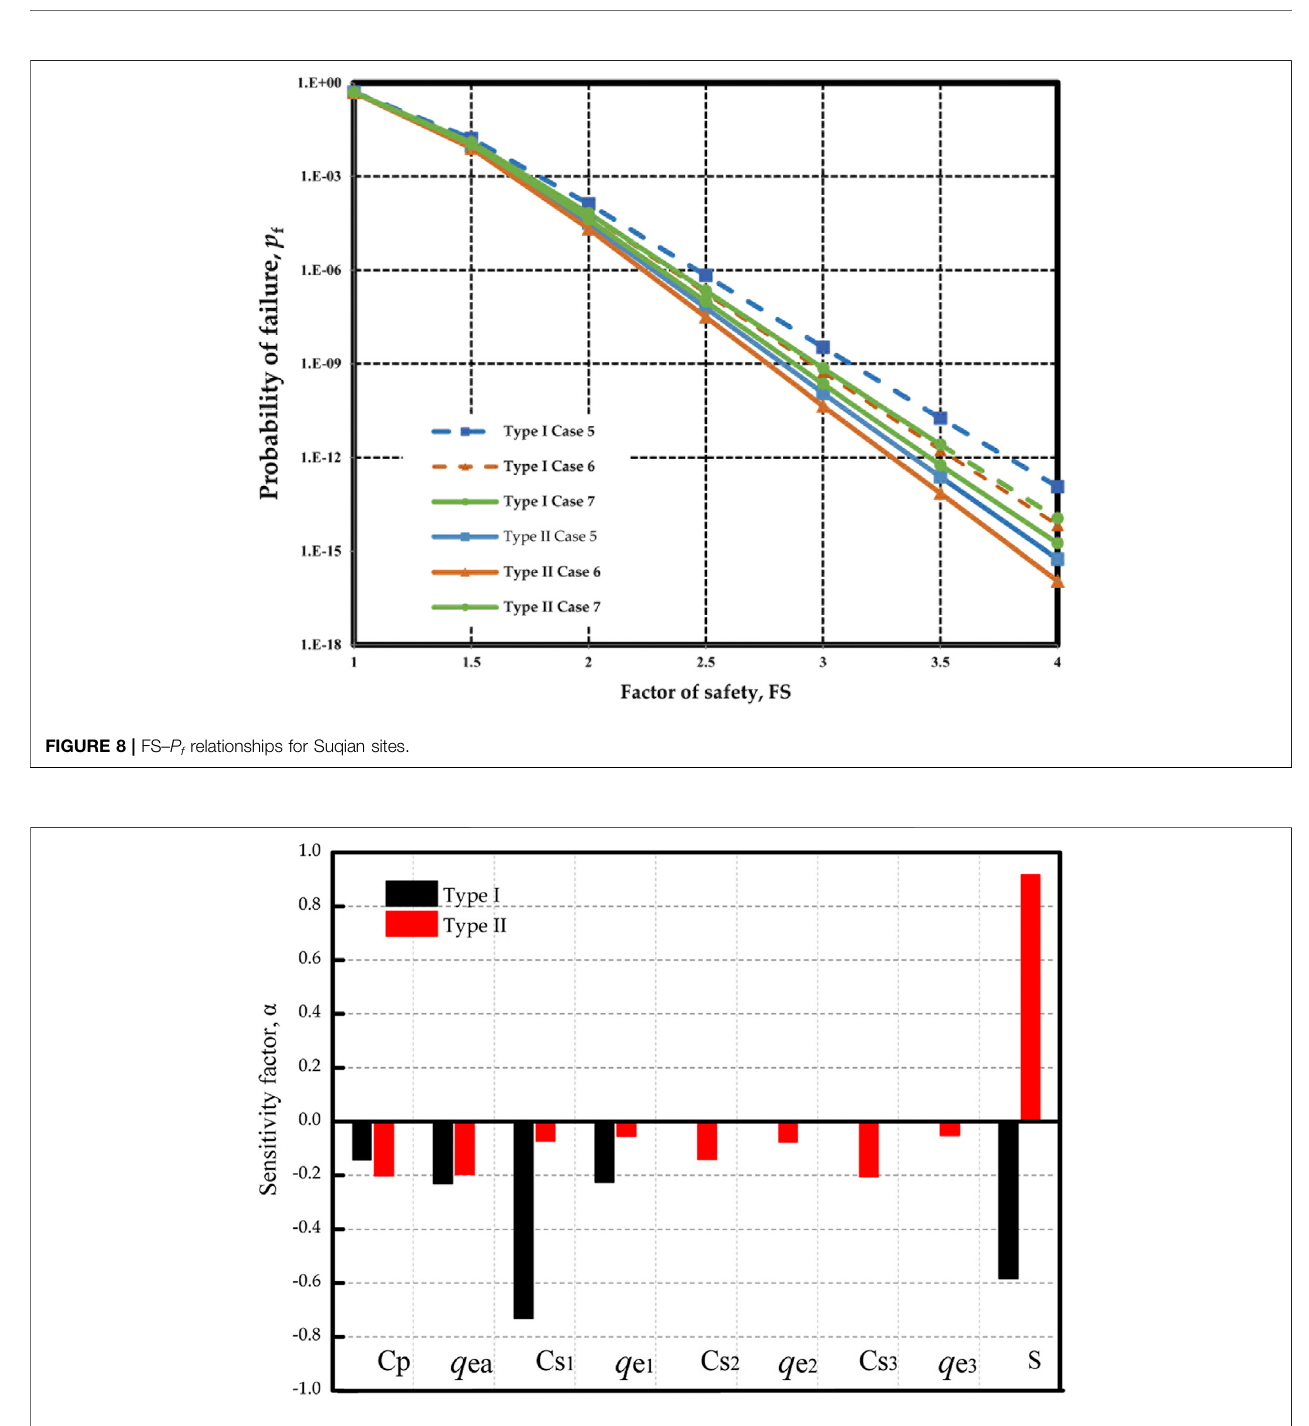
FIGURE 9 | Sensitivity factors for Case